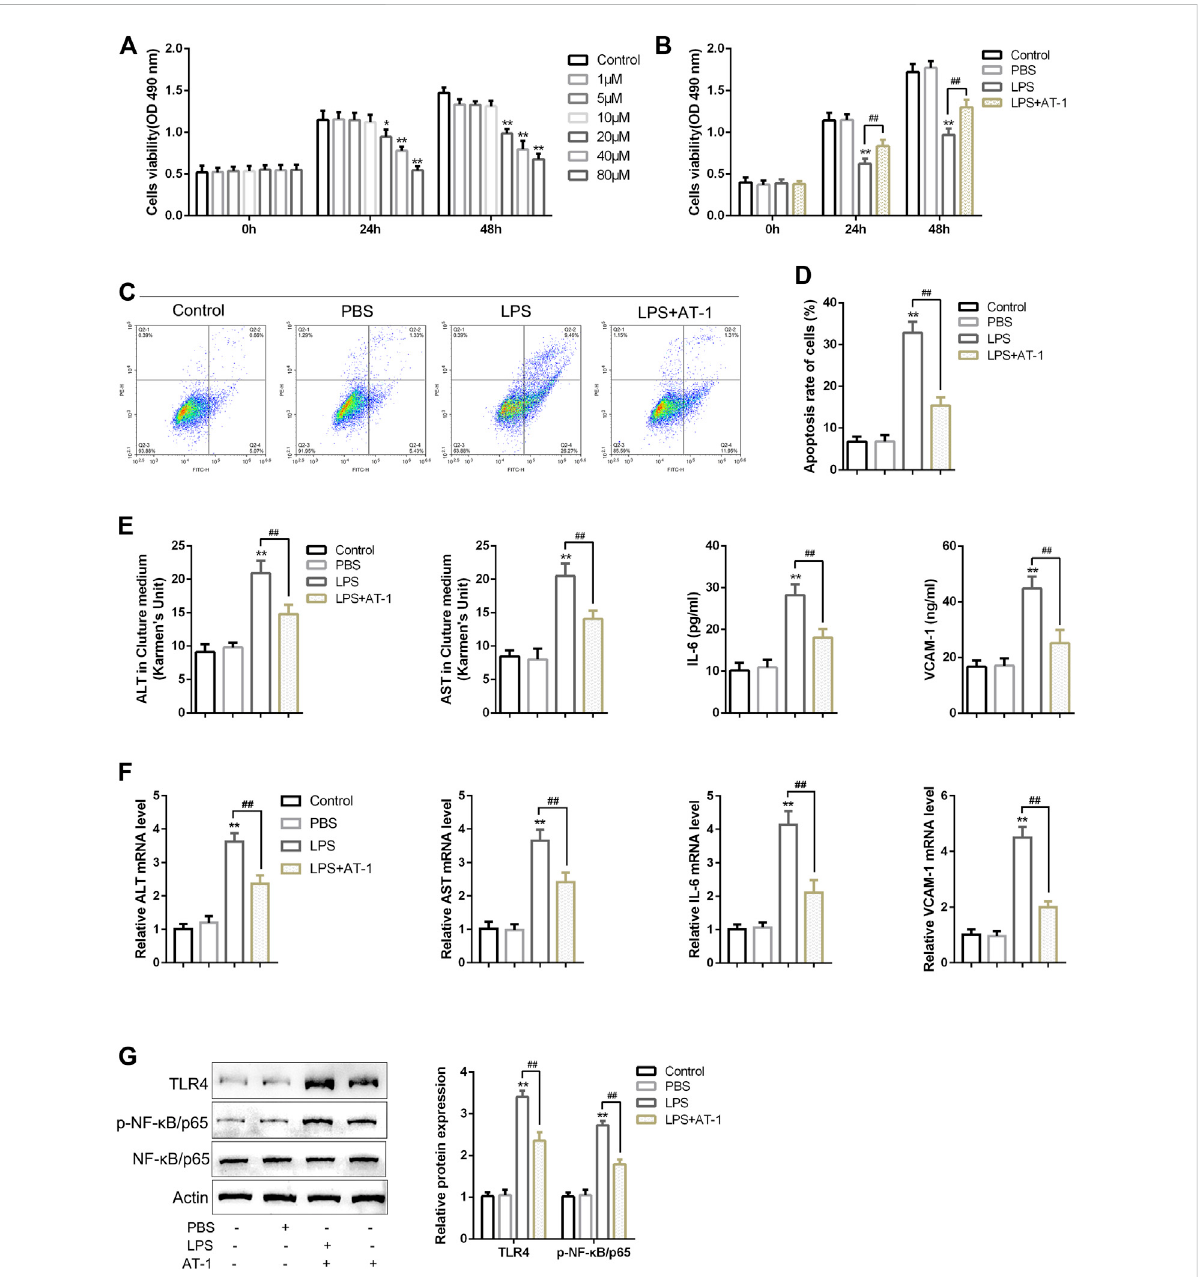
FIGURE 4 EffectsofatractylenolideI(AT-1)onLPS-inducedtoxicityinrathepatocytes. (A) BRL3AcellsweretreatedwithgradientdosesofAT-1(0,1,5,10, 20, 40, and 80 µM) for different time points and examined for cell viability using CCK-8 assays. Then, BRL 3A cells were treated with LPS in the presence or absence of 10 µM AT-1 and examined for cell viability using the CCK-8 assay (B) , cell apoptosis by fl ow cytometry (C – D) , the levels of ALT, AST, IL-6, and VCAM-1 in culture medium or cells using corresponding kits or qRT-PCR assay, respectively (E – F) , and the protein levels of TLR4,p-NF- κ B/p65,andNF- κ B/p65byimmunoblotting (G) .N=3;* p < 0.05,** p < 0.01comparedtothecontrolgroup;## p < 0.01comparedtothe LPS